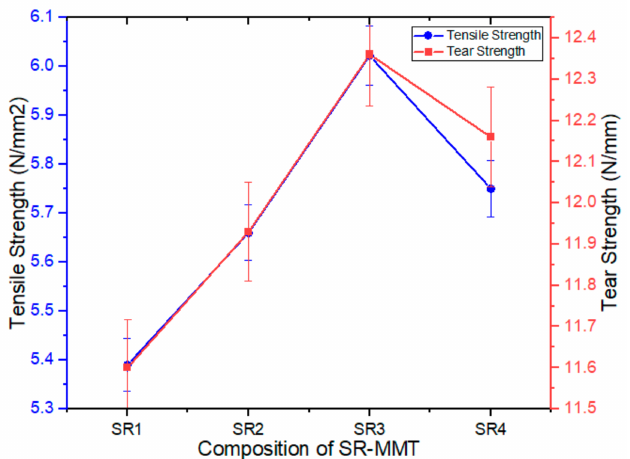
Figure 5. Variation of tensile strength and tear strength of SR–MMT nanocomposites with weight % of